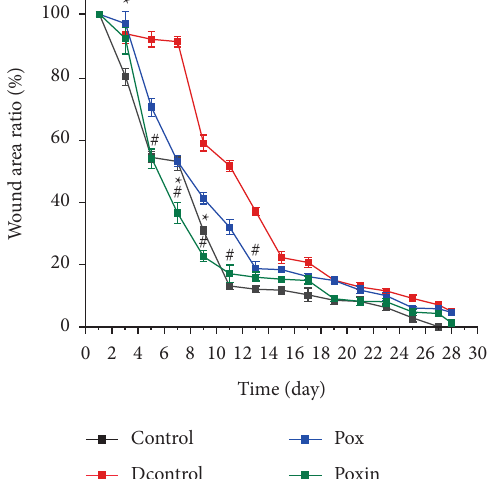
Figure 4: Percent of closure is shown on the graphic. Data were expressed as the mean ± SE of three mice per group. ∗ P < 0 . 05, the Poxin group vs. the Control group. # P < 0.05, the Poxin group vs . the DControl